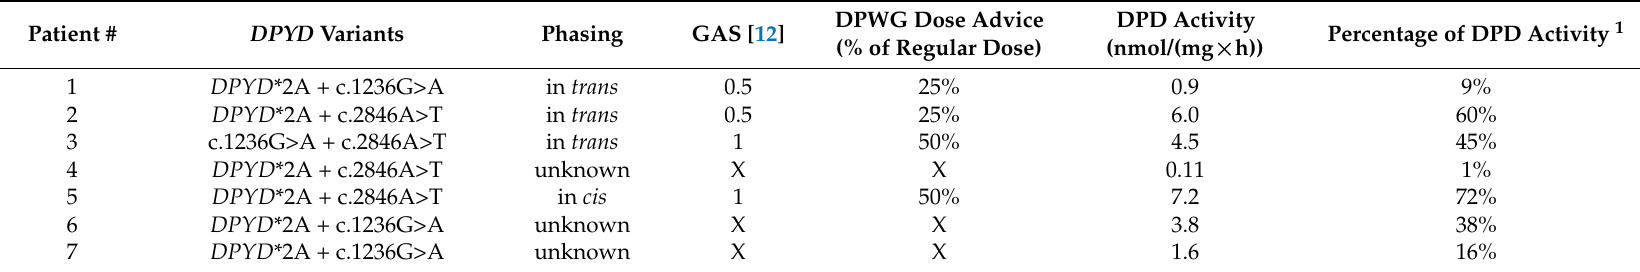
Table 2. Dose advice for compound heterozygous DPYD variant allele carriers. Shown per patient are DPYD variants, phasing of the DPYD variants, GAS, retrospective DPWG dosing advice based on phasing, DPD enzyme activity, and percentage of DPD enzyme activity considered for dose advice. According to the DPWG guidelines [19], a gene activity score can be given to compound heterozygous patients when phasing is known. Fully functional/reduced functionality = gene activity score of 1.5; fully functional/inactive = gene activity score of 1; reduced functionality/reduced functionality = gene activity score of 1; reduced functionality/inactive = gene activity score of 0.5; inactive/inactive = gene activity score of 0. Abbreviations: DPD: dihydropyrimidine dehydrogenase; GAS: gene activity score; DPWG: Dutch Pharmacogenetic Working Group; X: could not be